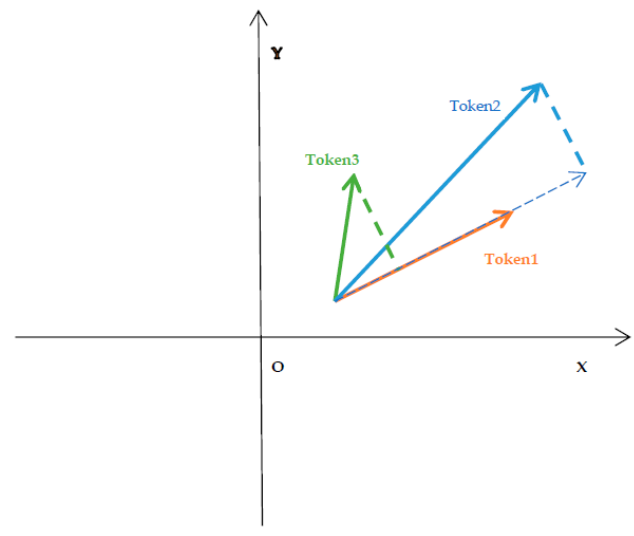
Figure 2. Schematic diagram of contribution weight of two-dimensional tokens.